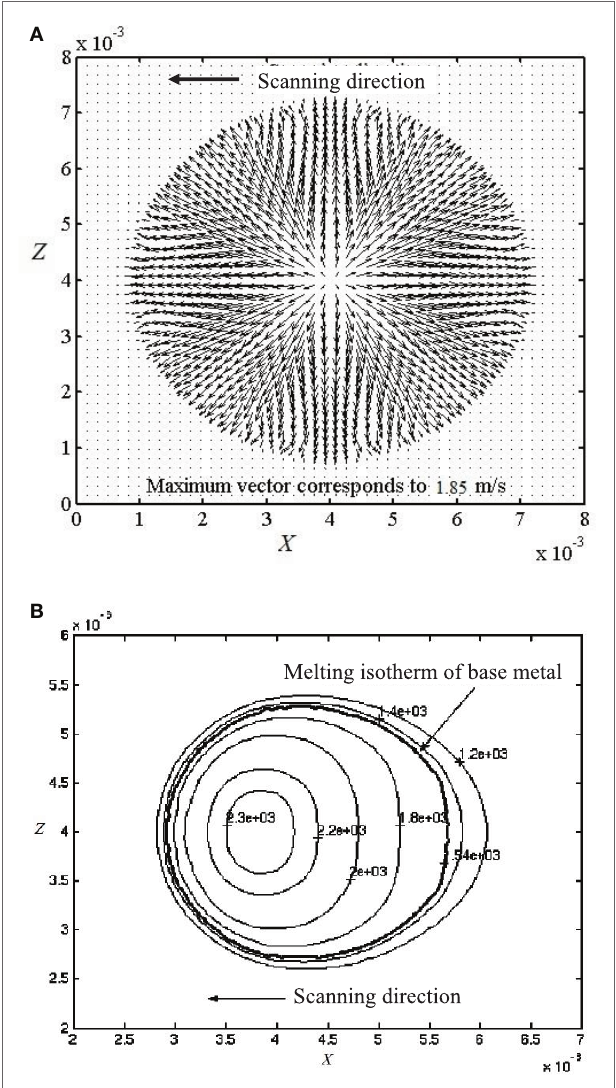
FIGURE 2 | (A) Velocity and (B) temperature fields on the top surface of the substrate obtained from the k – ε turbulence model.